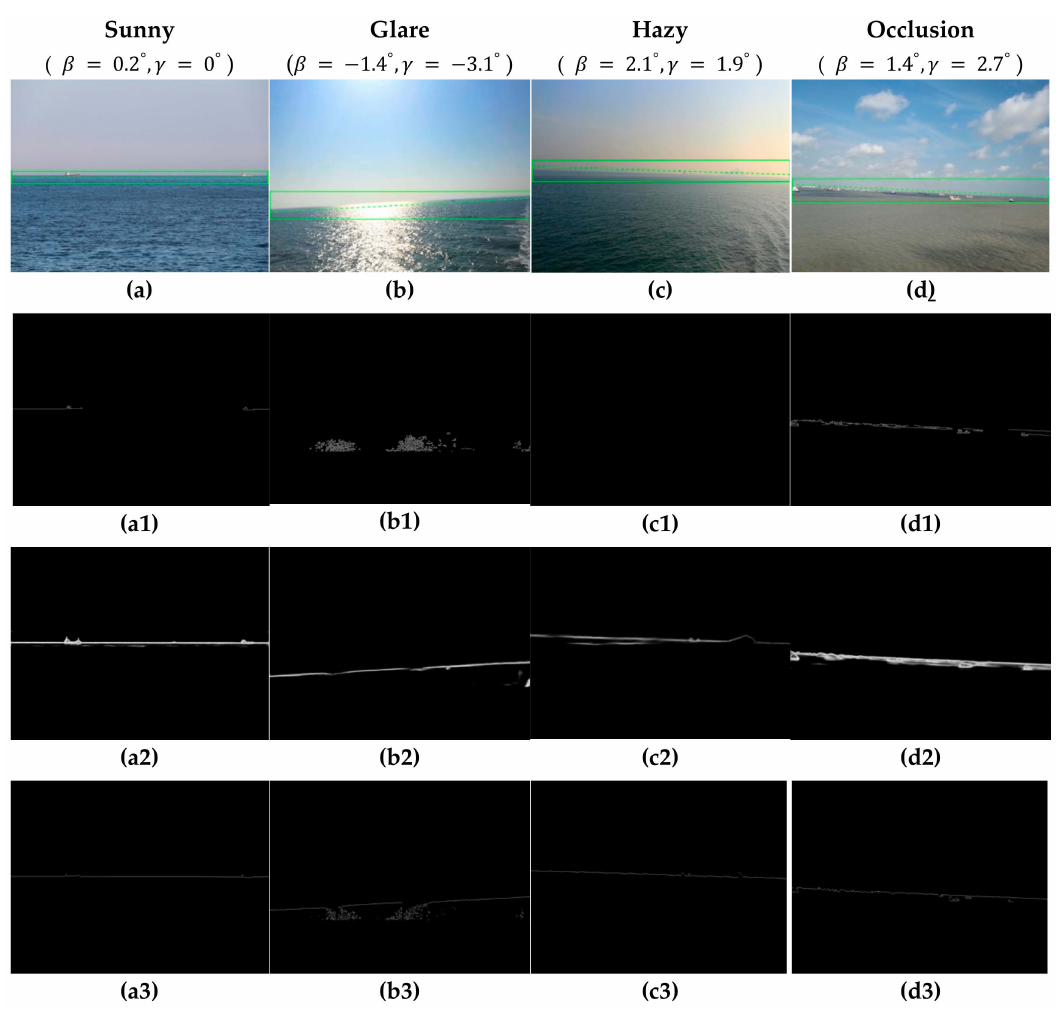
Figure 10. Edge detection results by the four method. ( a – d ) Original images with CR. ( a1 – d1 ) Edge detection results by Canny (30,150). ( a2 – d2 ) Edge detection results by HED. ( a3 – d3 ) Edge detection results by the proposed